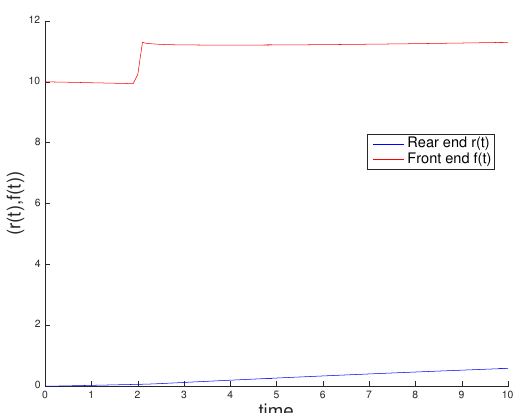
Figure 7. Evolution of the rear and front ends of the cell body during 10 s of simulation. The cell migration process continues after the deactivation of the external forces.